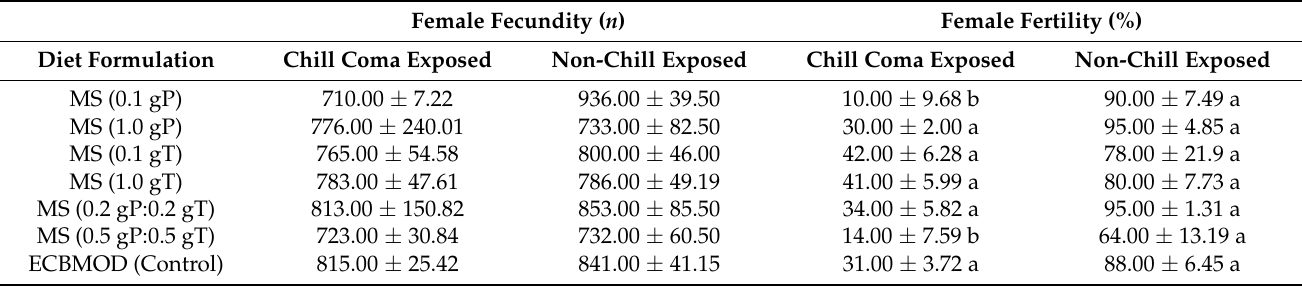
Table 10. Mean ( ± SE) fecundity of chill coma exposed and non-chill exposed Eldana saccharina female moths [ n = 15] and their egg fertility after mating with males from the same formulations but not exposed to chill coma, from the MS (0.1 gP), MS (1.0 gP), MS (0.1 gT), MS (1.0 gT), MS (0.2 gP:0.2 gT), MS (0.5 gP:0.5 gT) and ECBMOD control diets. Means followed by different lower-case letters in a line indicate significant differences ( p <